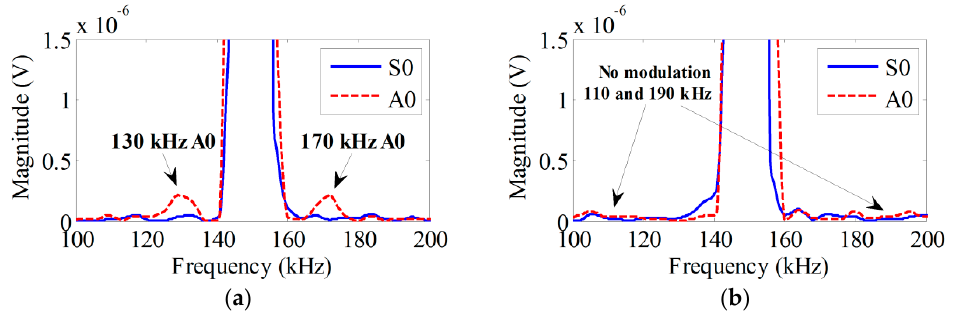
Figure 6. The S0 mode modulation is generated at 246 kHz only when the nonzero power flux and synchronism condition are matched (both primary waves at 210 kHz and 456 kHz are S0 mode).